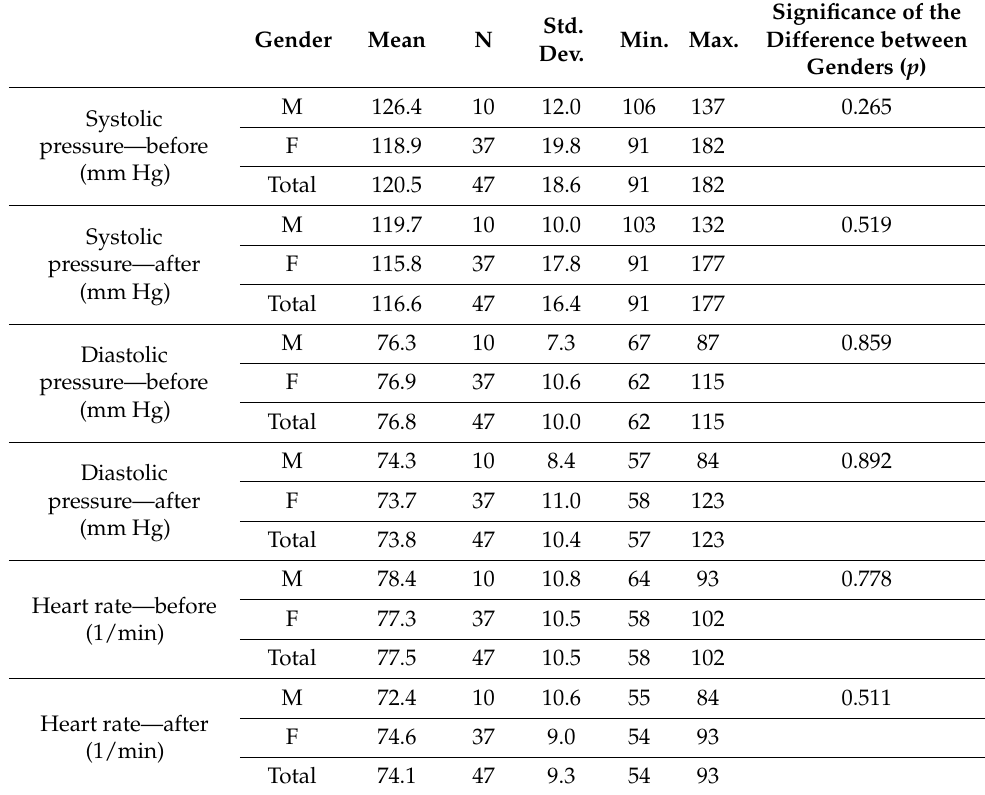
Table 2. Average values of heart parameters (pressure and rate) before and after forest therapy.